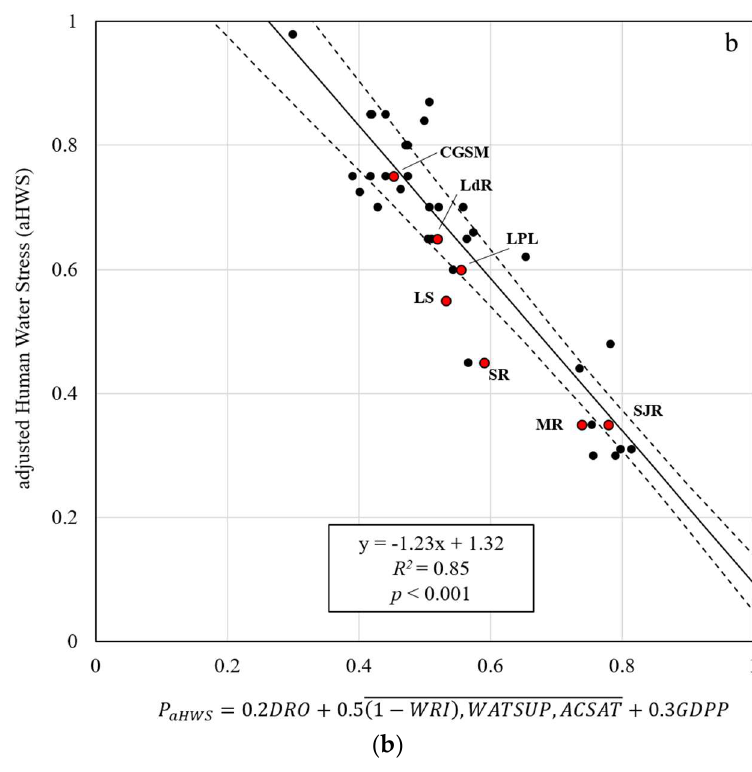
Figure 4. Regression analysis for ecosystem service water supply benchmark aHWS (adjusted Human Water Stress; [14]) as a function of proxy (PaHWS) obtained using external, internal and socioeconomic indicators (Table 2): ( a ) regression results for GDPP as single proxy, and ( b ) best regression results for three-category proxy. Regression models (solid line; dashed lines 95% confidence interval) based on Ramsar sites (black circles), with SAFER sites (red circles) plotted for comparison.